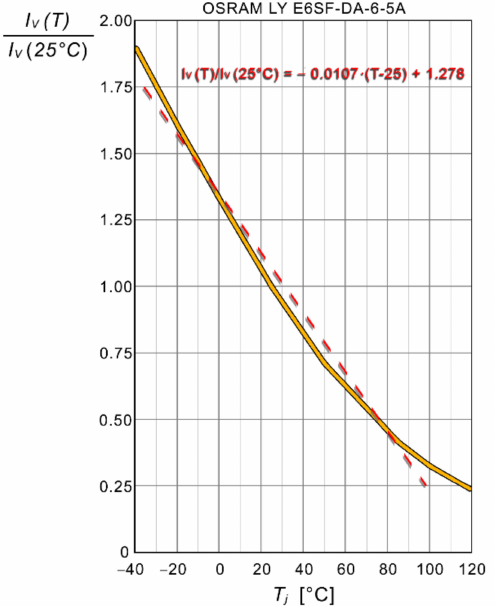
Figure 8. LY E6SF LEDs: temperature dependence of intensity. The linearization line is also shown. I V represents the light intensity emitted by the LED and the T j junction temperature. The light intensity is normalized to 1 when the bias current is 50 mA.